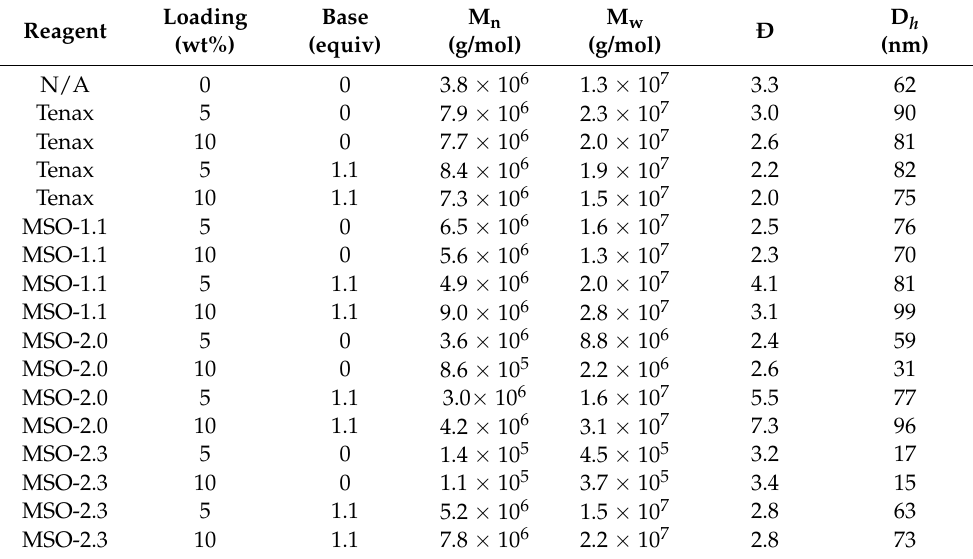
Table 6. Absolute molecular weight averages and hydrodynamic diameter of starch modified with TENAX and maleated soybean oil in the melt